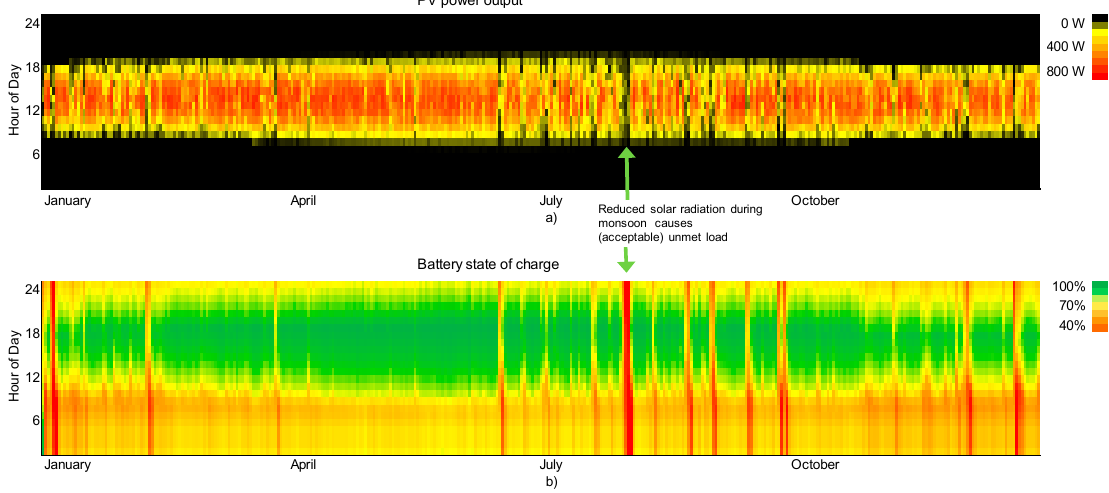
Figure 14. Power output from 900 Wp PV panel ( a ) and corresponding State of Charge (SoC) ( b ). During the trial the station was continuously running on the given solar PV system, as long as